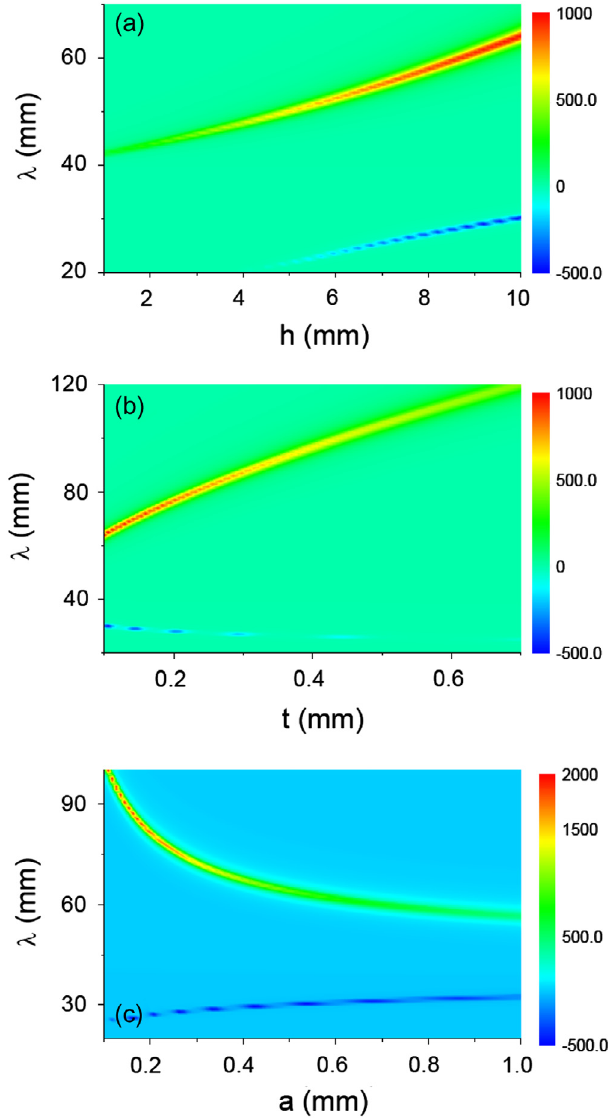
Figure 7. The SFP-resonance induced electromagnetic pressure in the microwave band as a function of wavelength and structure sizes: (a) a = 0.5 mm, t = 0.1 mm; (b) a = 0.5 mm, h = 10 mm; and (c) h = 10 mm, t = 0.1 mm. The lattice constant is fixed as d = 20